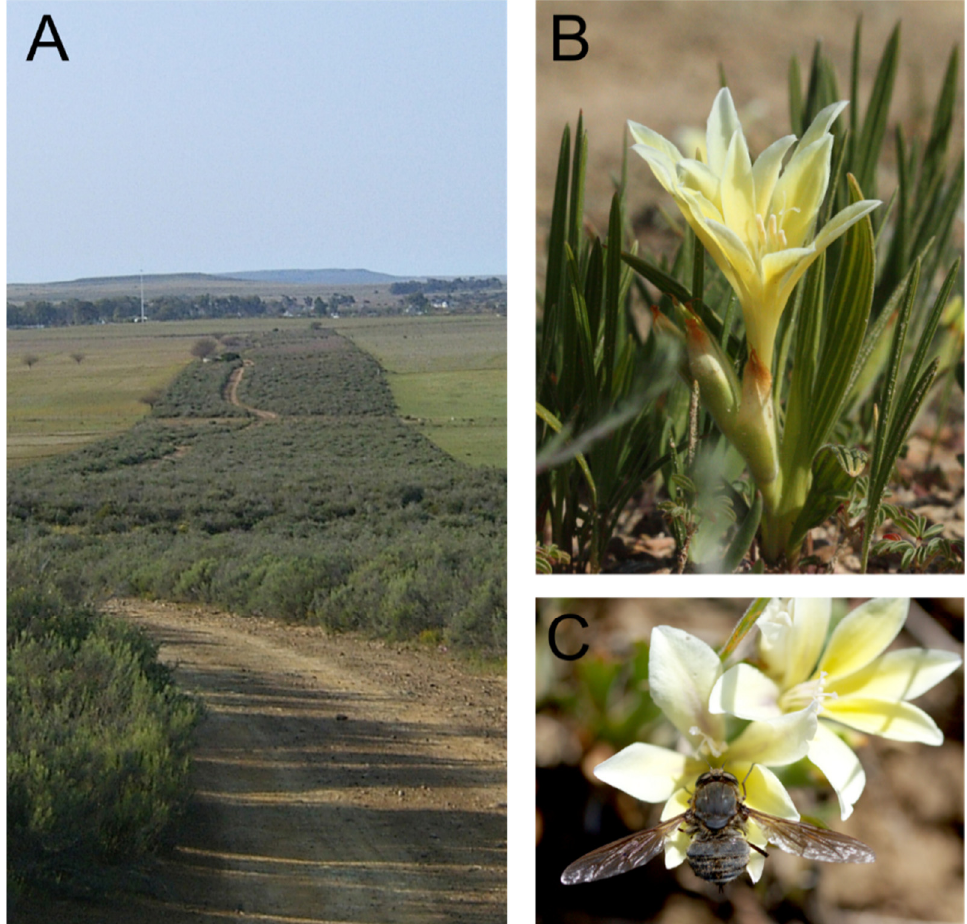
Figure 1. Study area in the Northern Cape Province, South Africa, (31°20 ′ 54” S, 19°05 ′ 30” E), nectar hostplant and visiting fly. ( A ) A small isolated area with natural Shale Renosterveld vegetation surrounded by transformed areas with grazed farmland. ( B ) Babiana vanzijliae (Iridaceae), the only available nectar host plant for ( C ) Prosoeca marinusi (Nemestrinidae) at the study site.